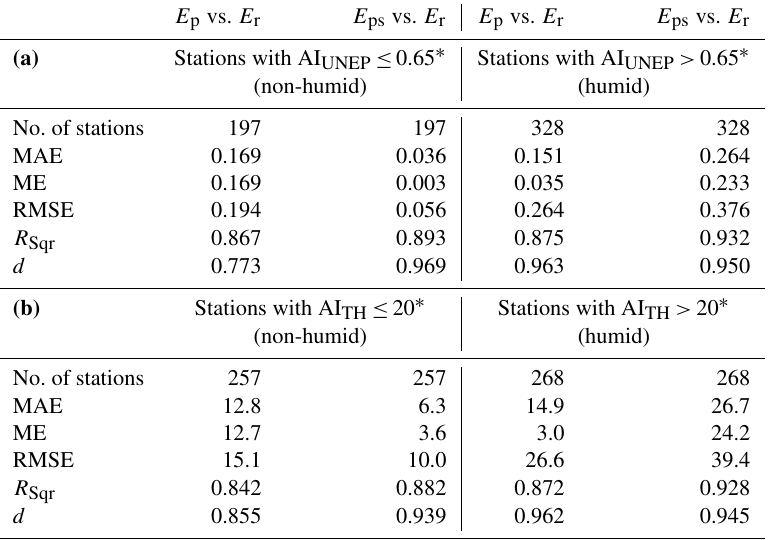
Table 2. Statistical metrics (Eqs. 12–16) for the comparisons between E p vs. E r and E ps vs. E r when they are applied in the (a) AI UNEP and (b) AI TH aridity indices by dividing the 525 stations into two groups based on non-humid or humid classes of each index (MAE, ME, and RMSE are unitless as the